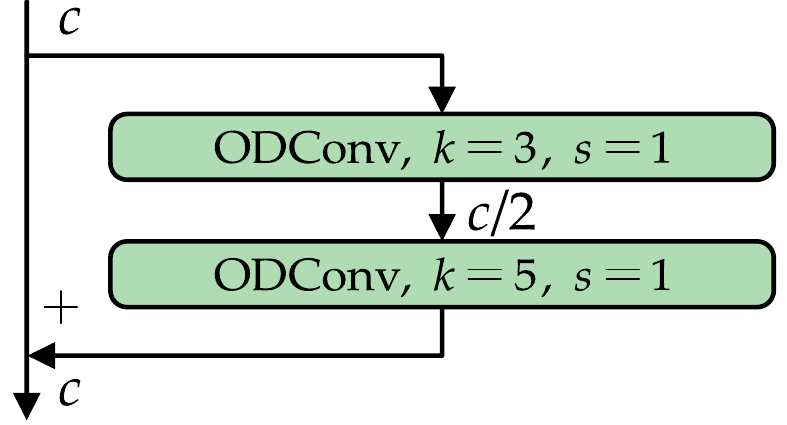
Figure 5. Schematic illustration of Block.